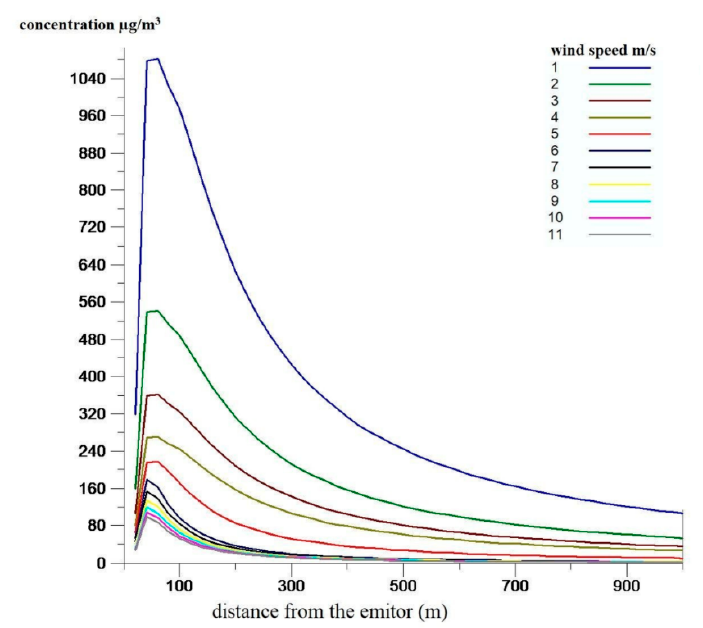
Figure 3. Variation in concentrations at various distances from the emitter depending on wind strength at ground level.